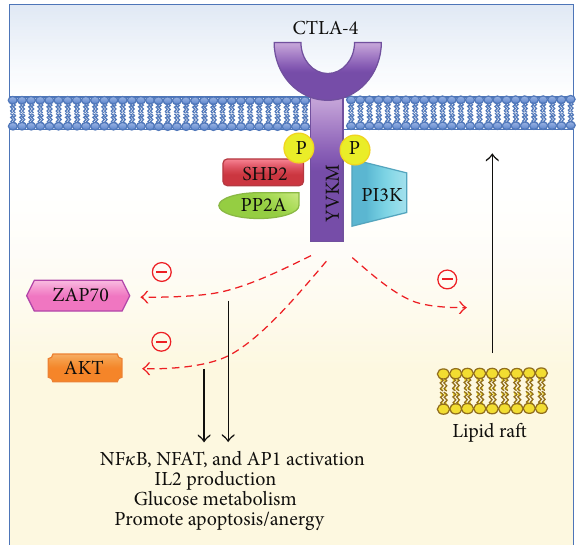
Figure 3: CTLA-4 signaling